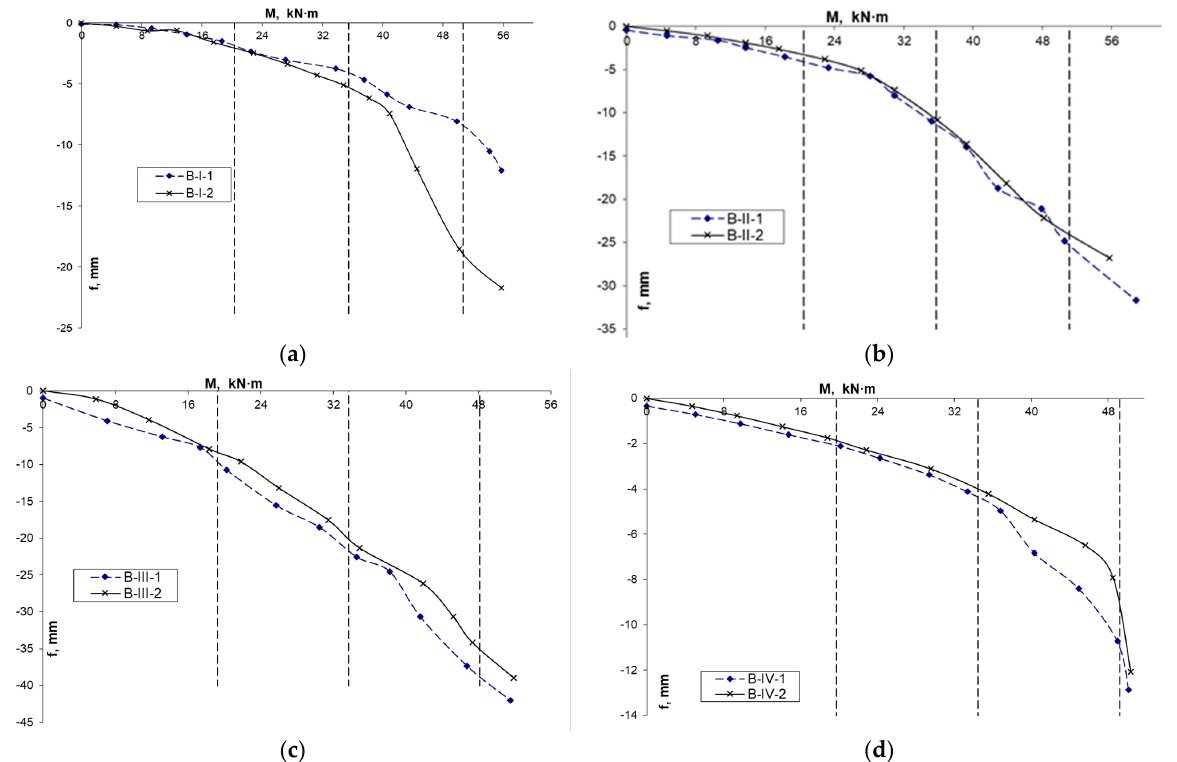
Figure 9. Graphs of the deflections in beams: ( a ) the development of deflections for series B − I; ( b ) the same for series B − II; ( c ) the same for series B − III; ( d ) the same for series B − IV; X-axis indicates experimental values of bending moment M (kNm); Y-axis indicates the corresponding deflections f (mm). Table 7. Experimental and theoretical values of deflections of test